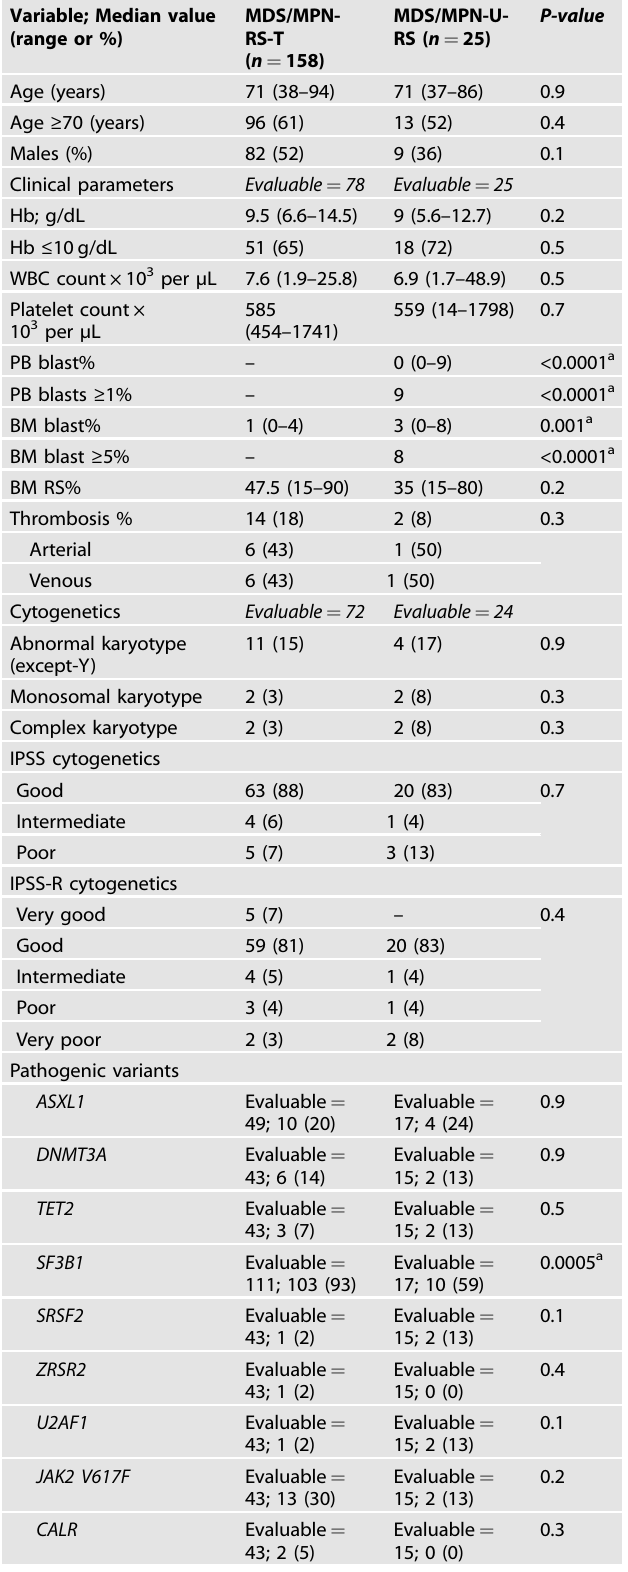
Table 1. Table showing phenotypic and genomic differences among patients with WHO-de fi ned MDS/MPN-RS-T and MDS/MPN-U patients with BM RS% ≥ 15